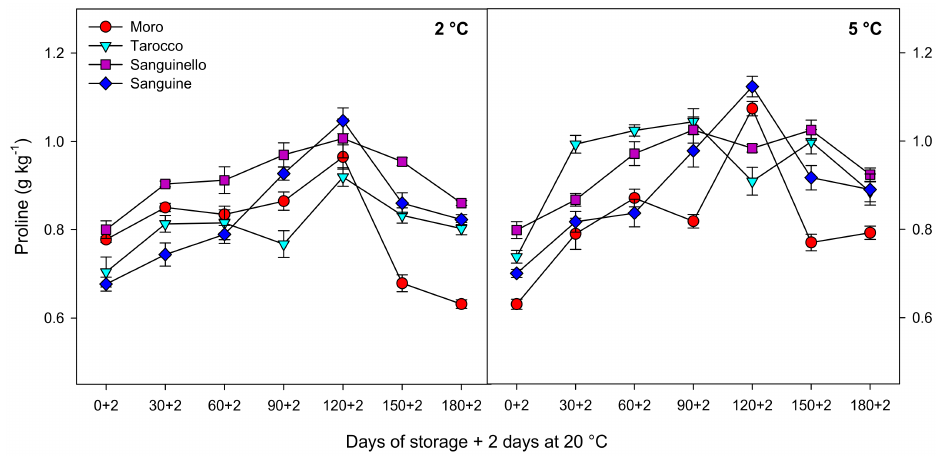
Figure 3. Changes in hydrogen peroxide (H 2 O 2 ), malondialdehyde (MDA) and proline content in the flavedo of blood orange cultivars (‘Moro’, ‘Tarocco’, ‘Sanguinello’ and ‘Sanguine’) during cold storage at 2 and 5 ◦ C and 90% relative humidity (RH) plus 2 days at 20 ◦ C. Vertical bars represent ± standard error (SE) of means. LSD ( p < 0.05) value is 0.19 for H 2 O 2 , 0.22 for MDA and 0.13 for